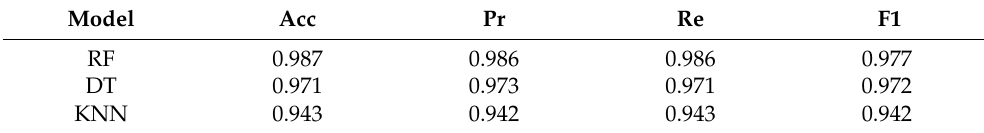
Table 5. Classifier results with considered metrics.